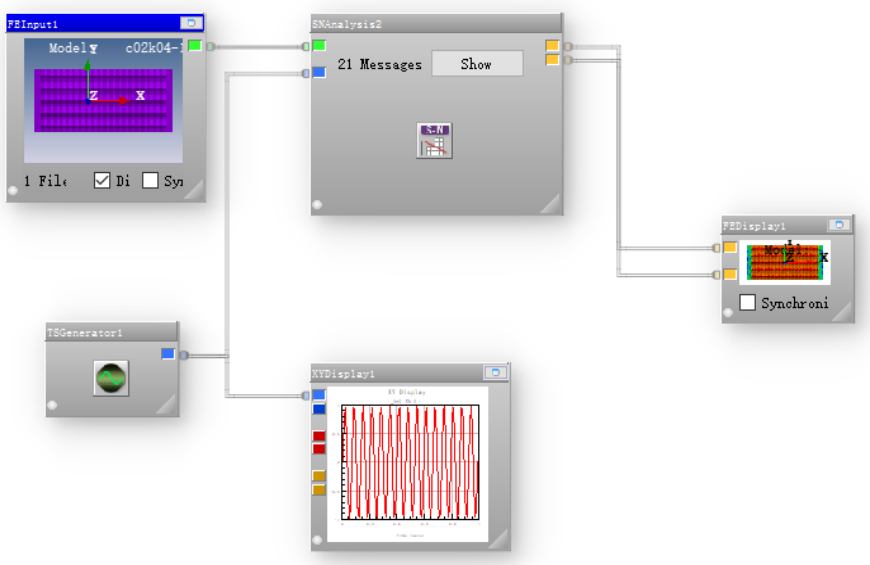
Figure 6. Flow chart of nCode fatigue analysis.